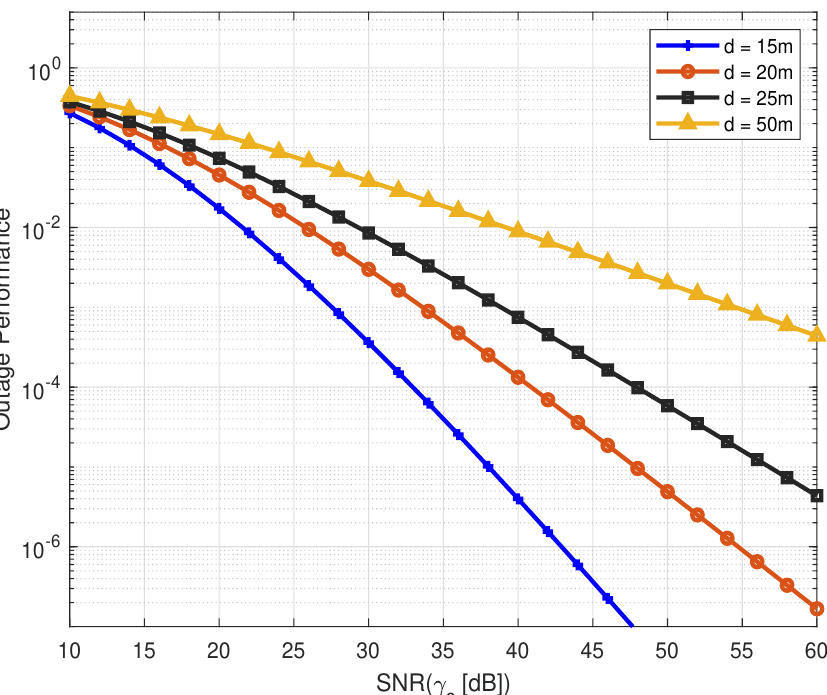
Figure 9. The outage performance of the system is depicted at the particular vertical distance of the communication setup in North ocean. The highest and minimum outage performances are depicted in different water conditions.